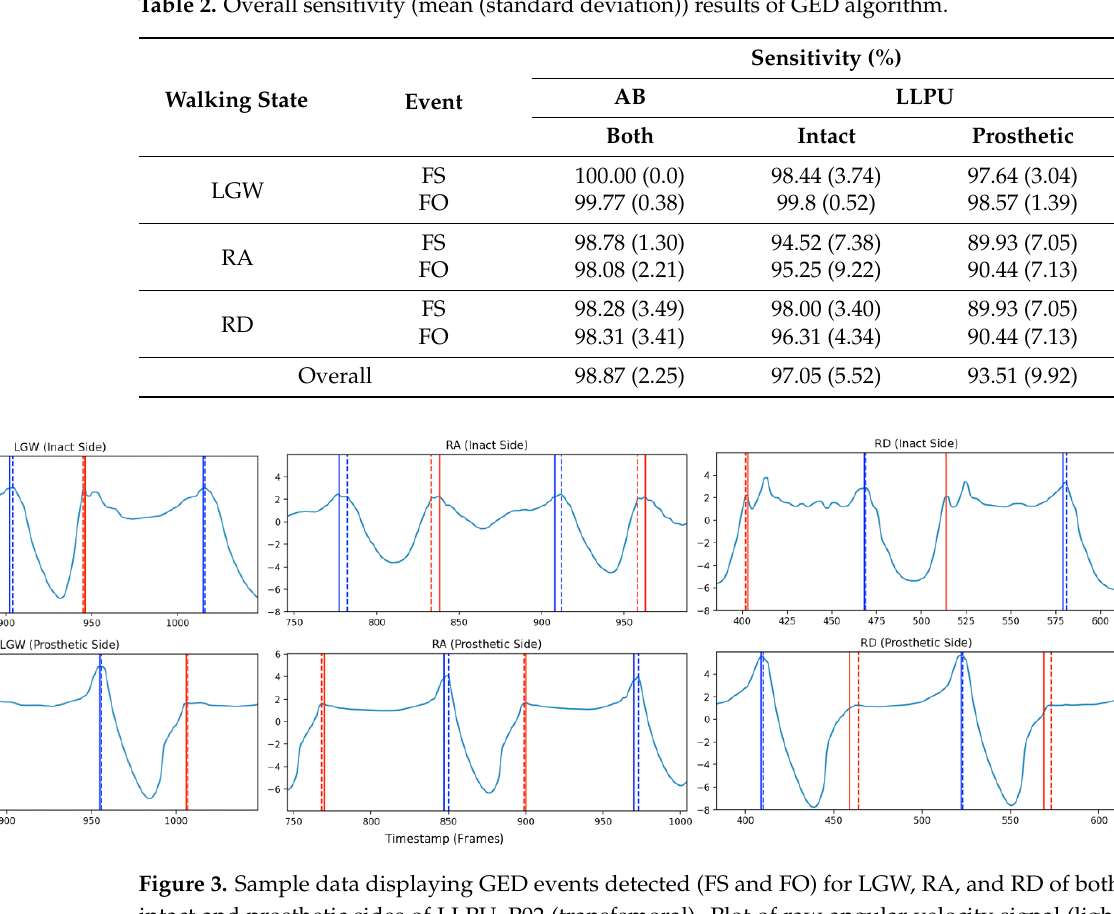
Table 2. Overall sensitivity (mean (standard deviation)) results of GED algorithm.